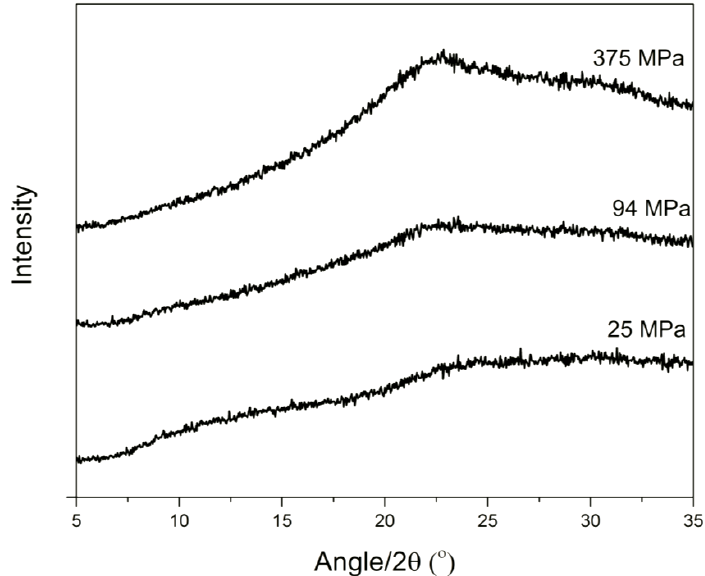
Figure 4. XRPD diffractograms for IND–PVP compacts after the dissolution test. The appearance of the halo confirms that the compacts are still amorphous after the dissolution